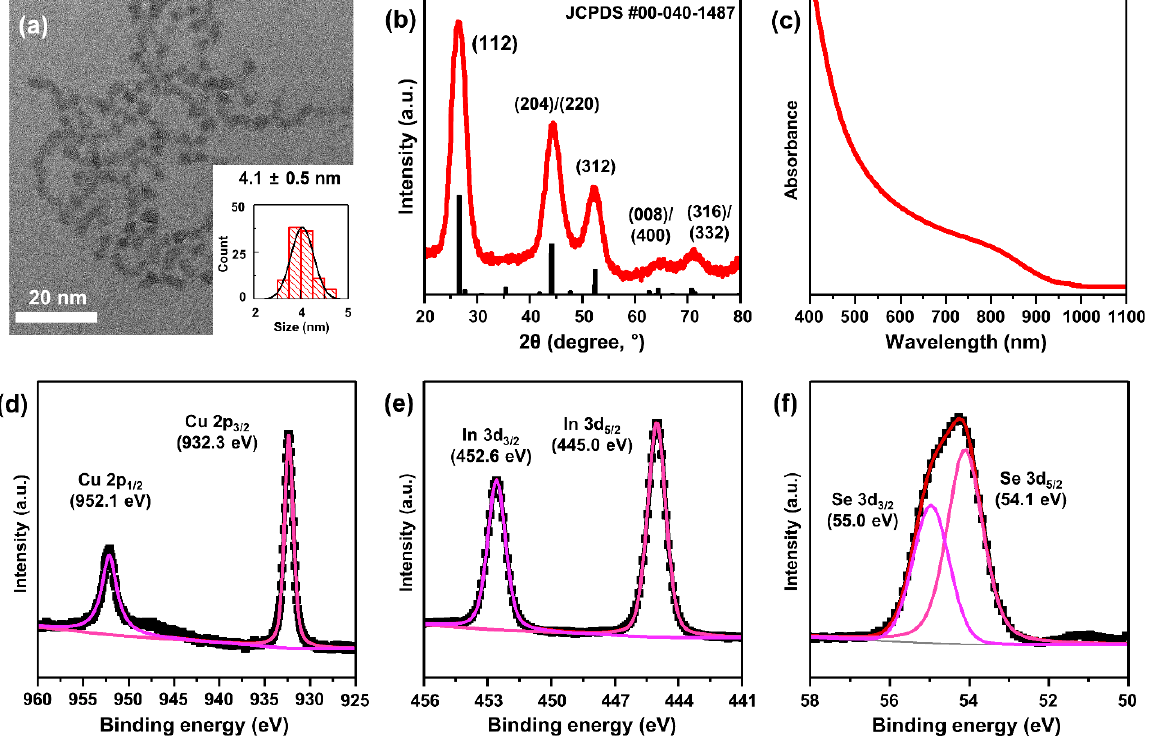
Figure 1. ( a ) TEM image of 4 nm-sized CISe QDs. Inset: histogram of the size distribution of the QDs (n = 100). ( b ) XRD pattern of CISe QDs. The reference XRD data of bulk chalcopyrite CuInSe 2 crystals are also shown (JCPDS No.: 00-040-1487). ( c ) Absorption spectrum of CISe QDs. XPS spectra of ( d ) Cu, ( e ) In, and ( f ) Se from the CISe QDs.